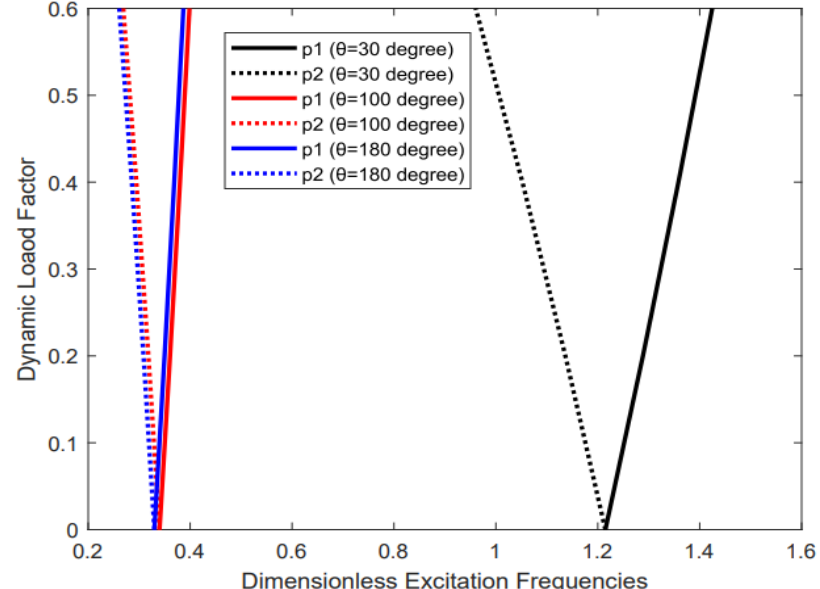
Figure 4. The effect of the panel angle.